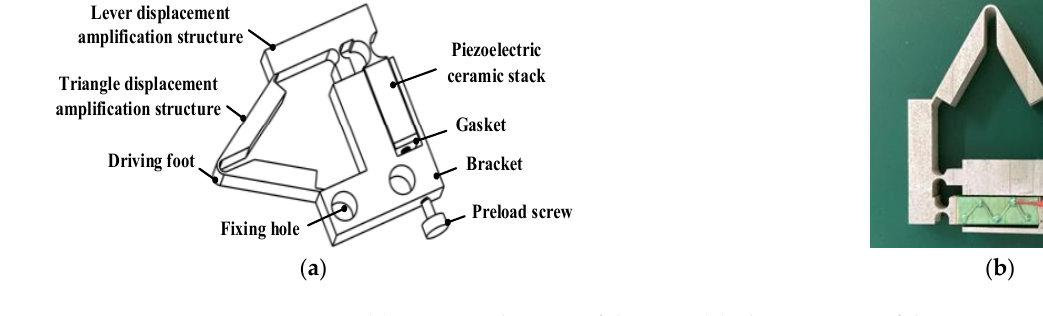
Figure 4. ( a ) Structure diagram of the PEA; ( b ) The prototype of the PEA.